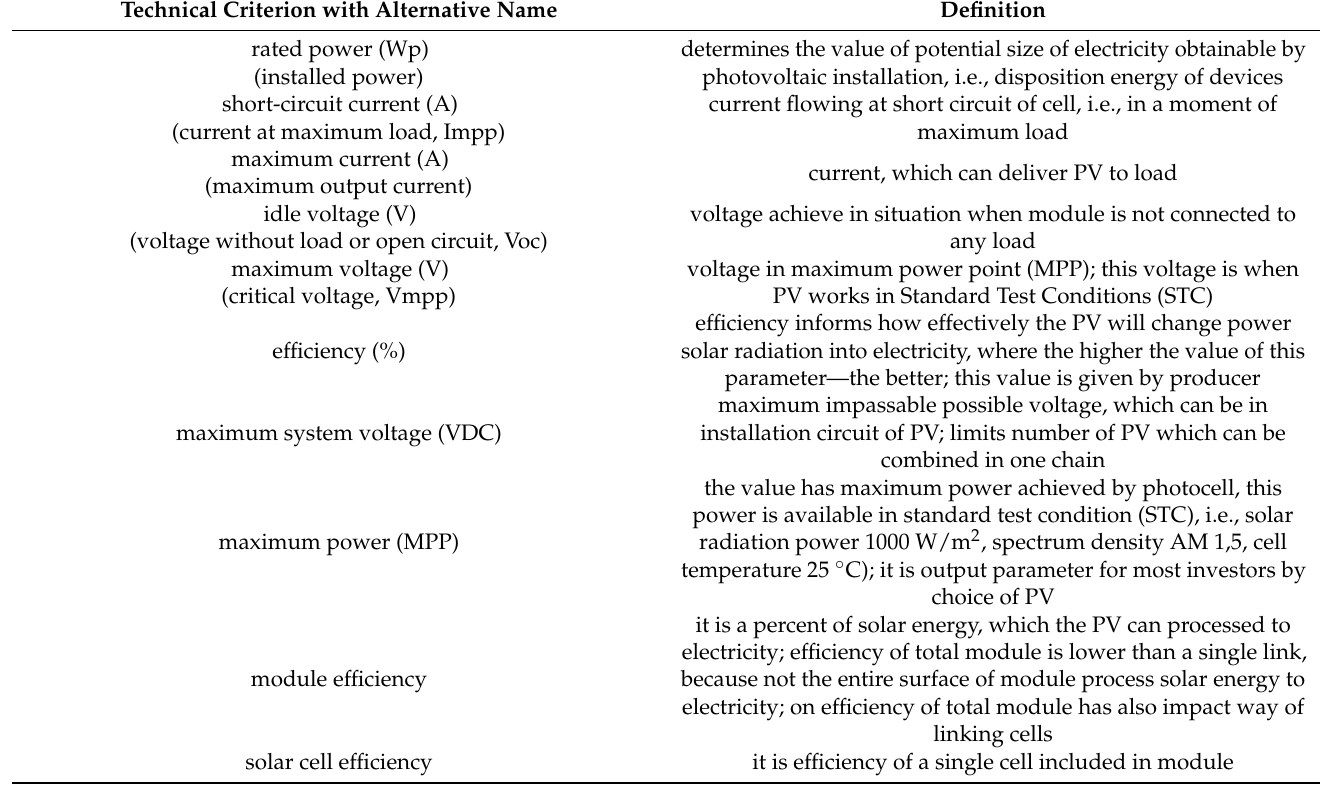
Table 1. Characteristics of main criteria of photovoltaic panels. Own study, based on